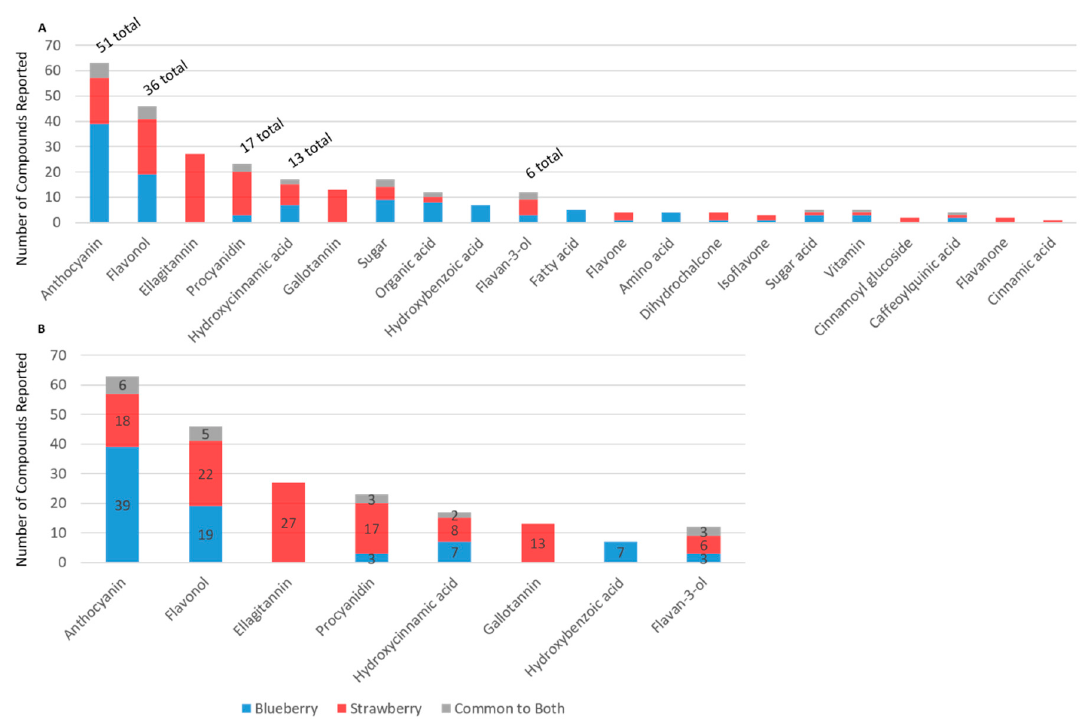
Figure 4. Distribution of secondary plant metabolites reported in the blueberry and strawberry. ( A ) Number of unique compounds reported in blueberry, strawberry, or common to both; ( B ) number of secondary plant metabolites/(poly)phenols reported in the most diverse (in number) subclasses.